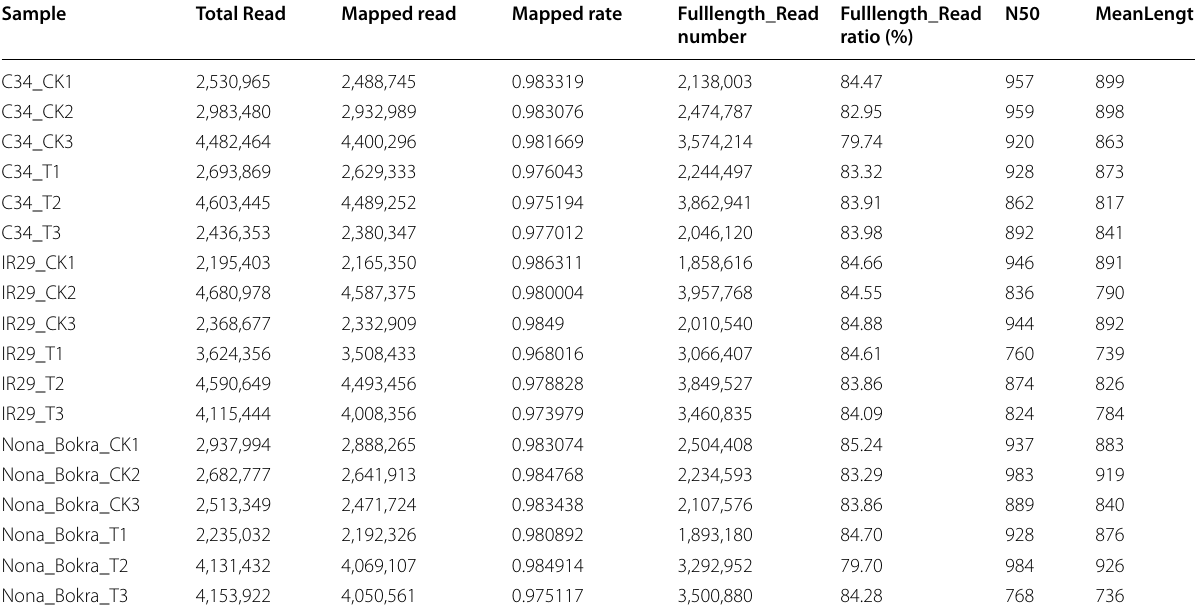
Table 1 An overview of RNA-Seq data quality Sample Total Read Mapped